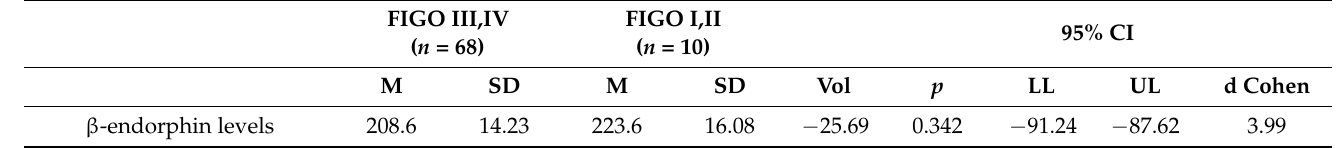
Table 4. The preoperative levels of β -endorphin in the group with ovarian cancer—III–IV stage according to FIGO and the group with ovarian cancer—I–II stage according to FIGO. FIGO III,IV